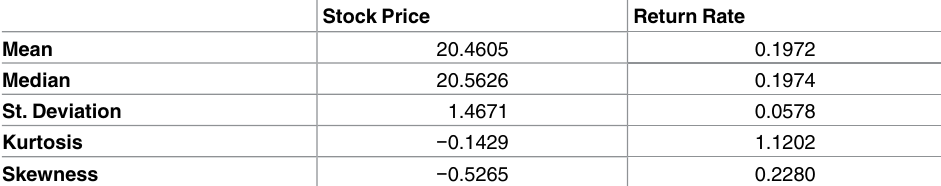
Table 2. Descriptive statistics (different types of agents with confidence). Source: Own